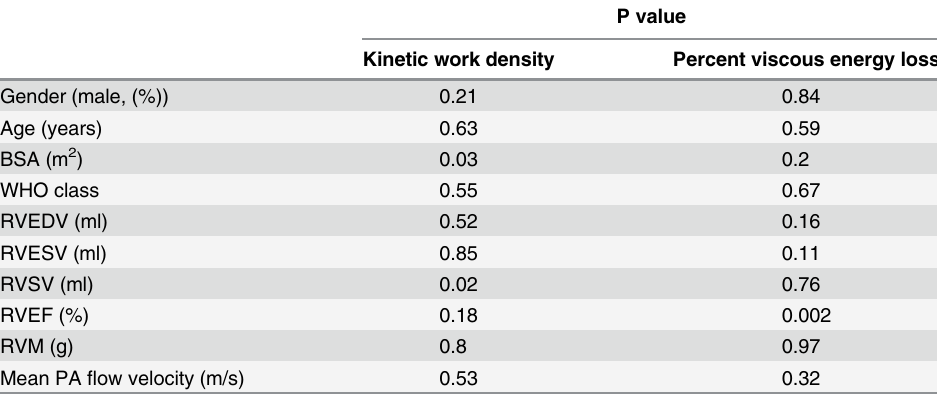
Table 3. Multivariate analysis of kinetic work density and percent viscous energy loss to demo- graphic and RV parameters. P value Kinetic work density Percent viscous energy